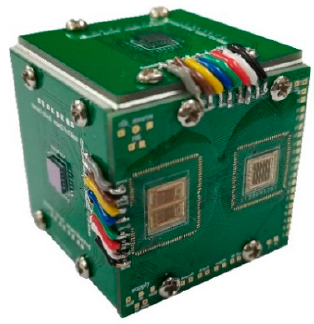
Figure 15. The implemented prototype gyroscope.